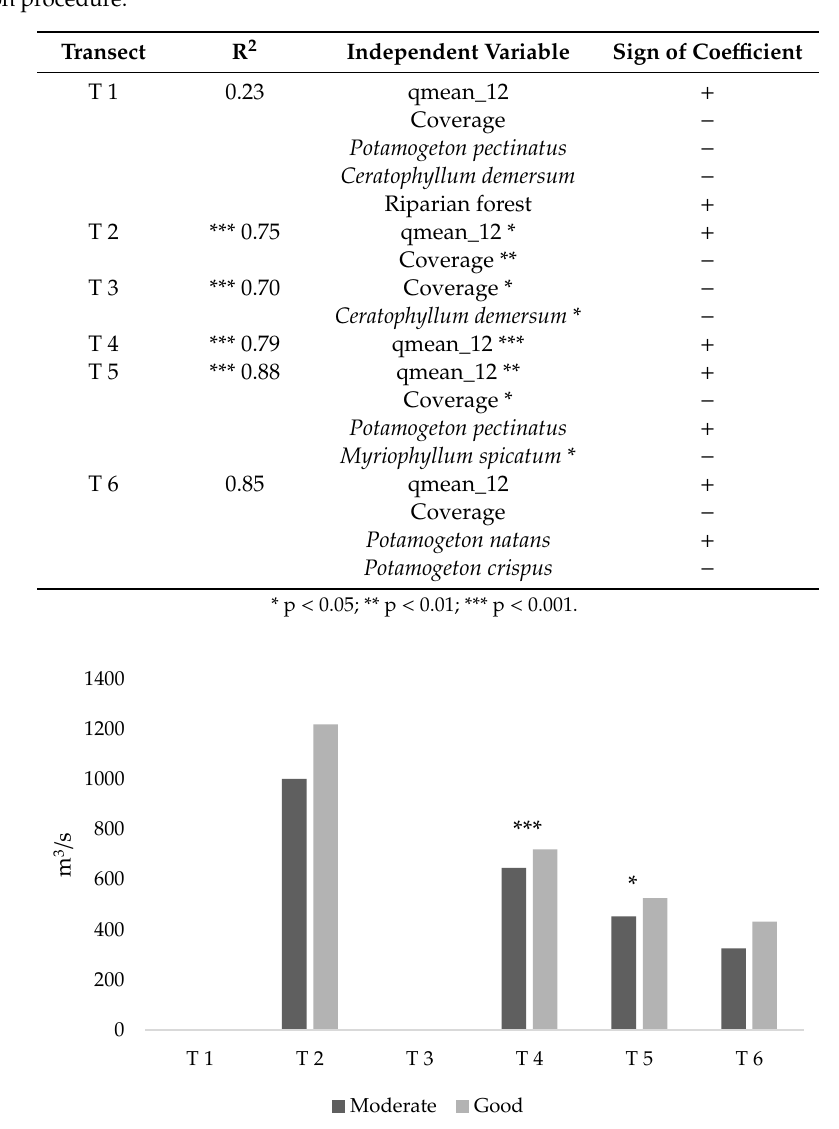
Table 5. Coefficients of determination (R 2 ) of the general linear models (GLMs) using bird species and groups as dependent variable and mean annual discharge as independent variable. Taxa and groups with non-significant values are not shown.